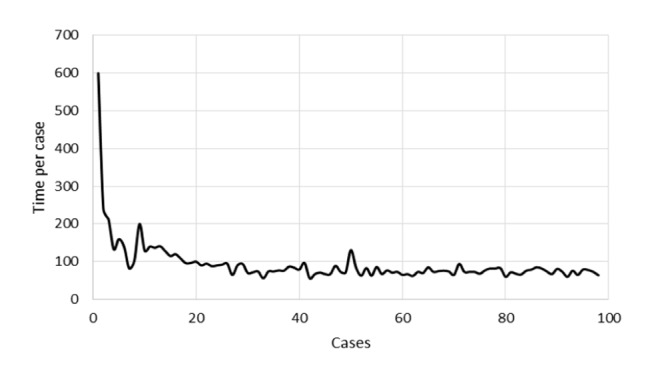
Entrytimepercase.